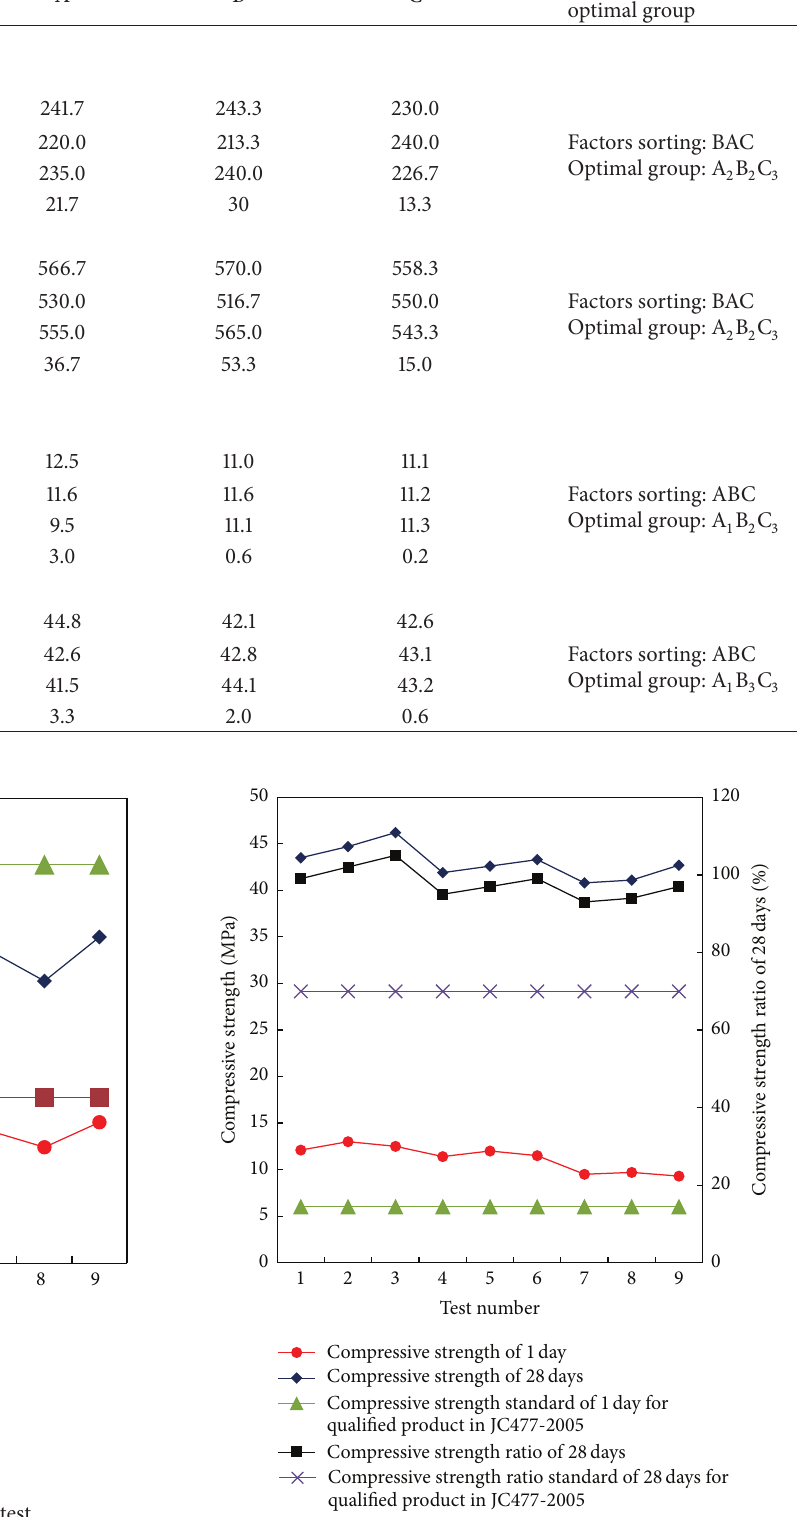
Figure 4: Compressive strength of orthogonal